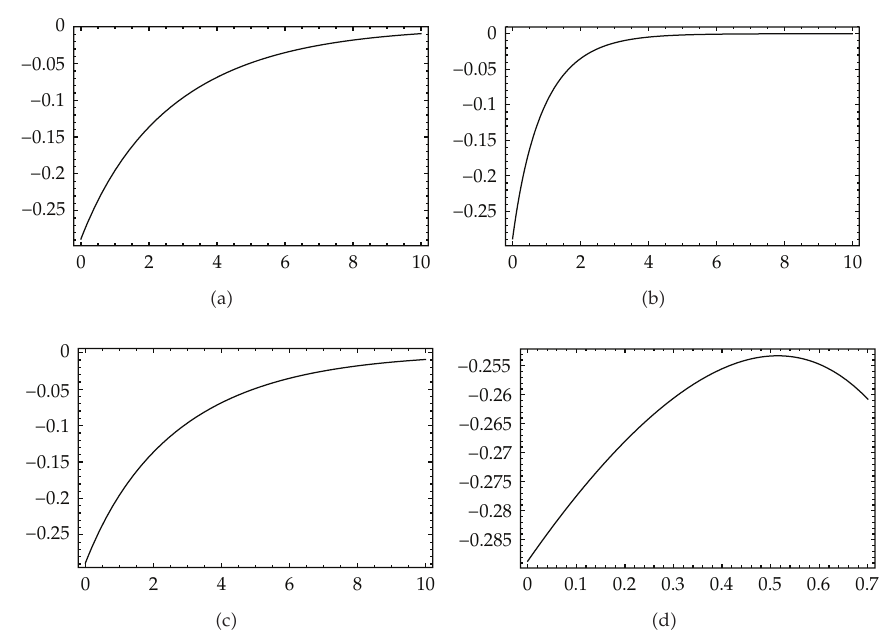
Figure 1: Plots of the Du ffi ng-van der pol equation: (cid:8) a (cid:9) RK4, (cid:8) b (cid:9) Chandrasekar et al. (cid:4) 15 (cid:5) , (cid:8) c (cid:9) present method, and (cid:8) d (cid:9) DTM (cid:4) 16 (cid:5) .